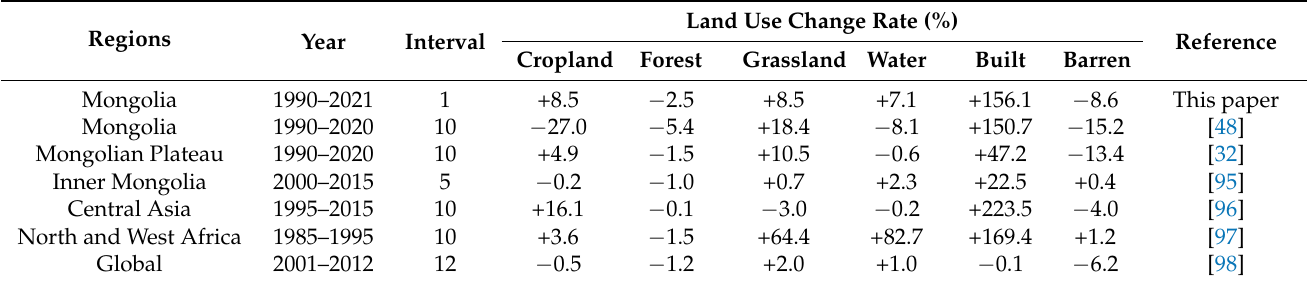
Table 6. Comparison of land use changes in Mongolia and other